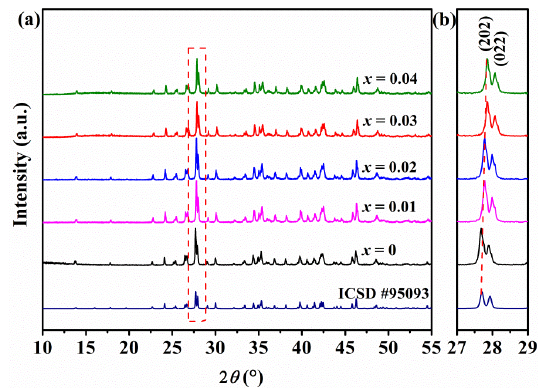
Fig. 1 (a) PXRD patterns of the samples Ag 8 Sn 1+ x Se 6 − 2 x Br 2 x ( x = 0, 0.01, 0.02, 0.03, and 0.04); (b) magnified XRD patterns in the 2 θ range of 27°–29° as marked by the red dotted rectangle.